Question: Describe this figure in one sentence.
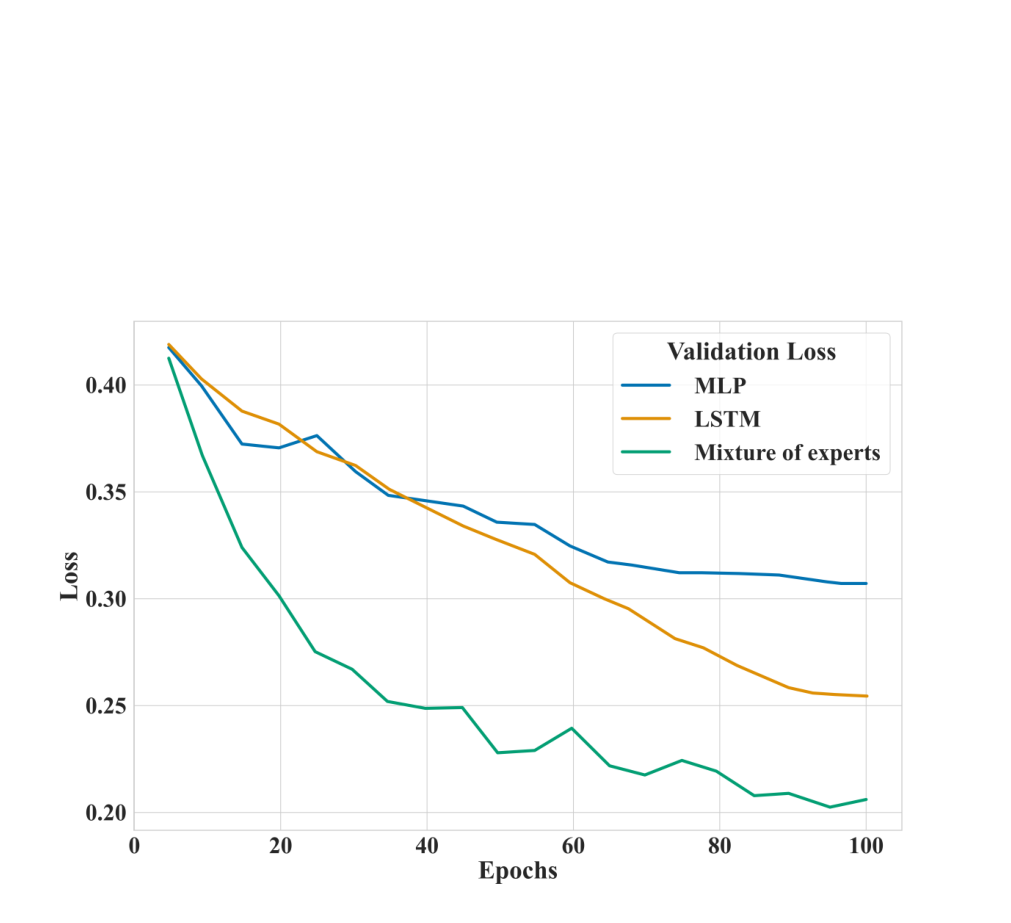
Answer: Validation losses for the prediction of protein structure scores from protein backbones. Results show a clear superiority of the mixture of experts network both in terms of speed of conver- gence and validation loss.